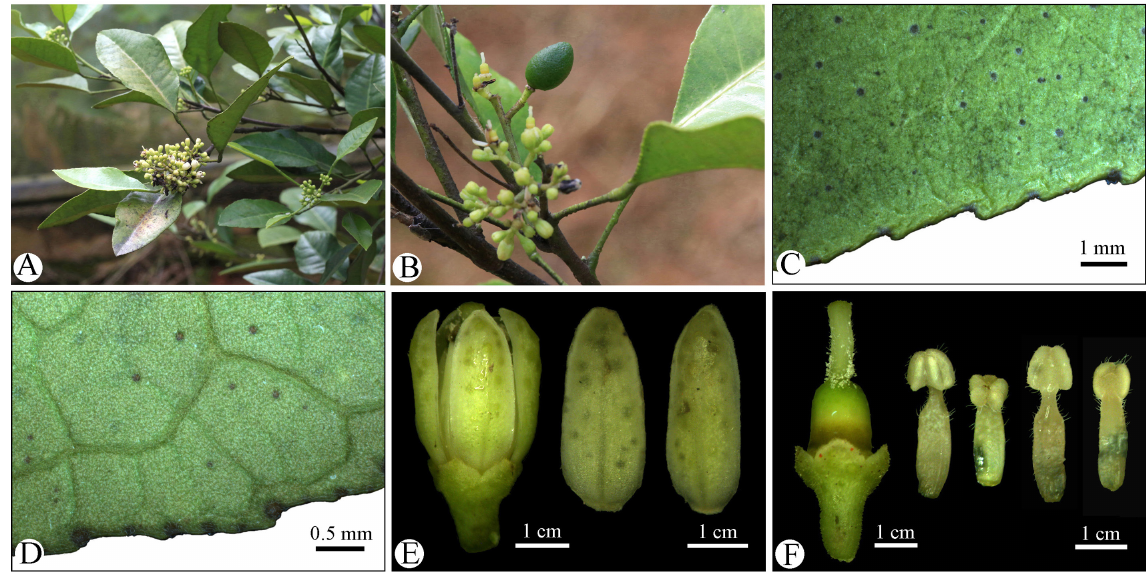
Fig. 14. Bergera unifolia C.L.Deng & F.J.Mou. A . Inflorescence. B . Fruit. C–D . Dorsal side of leaf. E . Flower. F . Flower parts. Photos taken by Feng-Juan Mou in